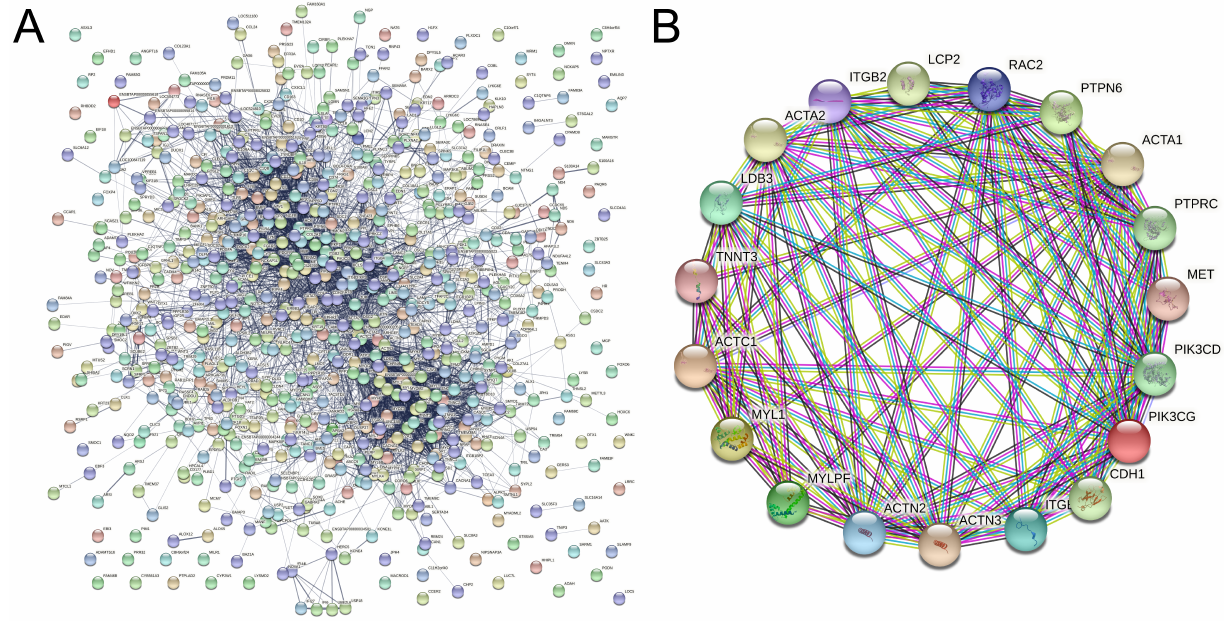
Figure 7. Results of differentially expressed protein interactions analysis. ( A ) Diagram of differentially expressed protein interaction network. ( B ) Hub protein interaction network